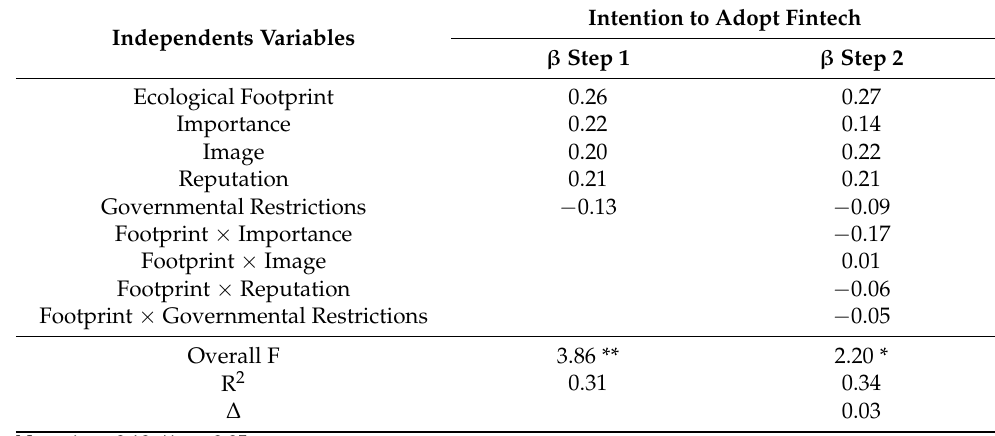
Table 6. Moderating effect of environmental context on the relationship between Ecological footprint